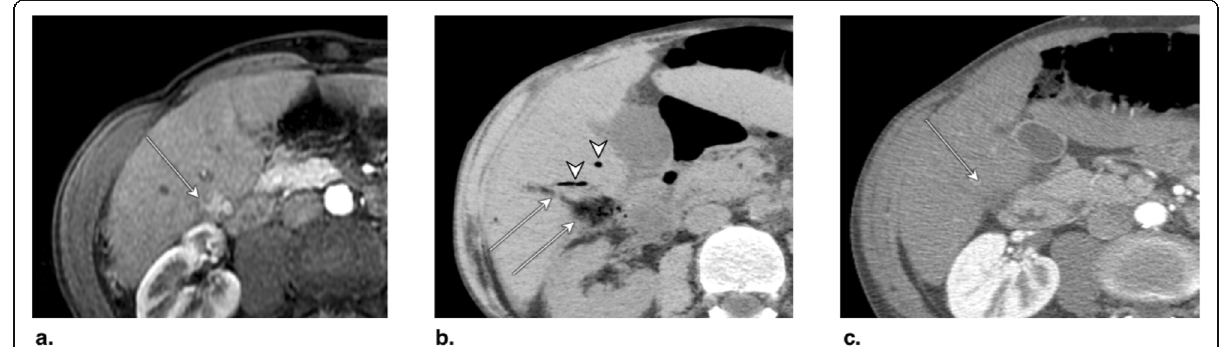
Fig. 8 a Axial T1-weighted MR in late arterial phase (AP) obtained pretreatment: image shows nonrim arterial phase hyperenhancement of a 2- cm LR-4 observation (arrow). b Axial-unenhanced CT MinIP obtained immediately post percutaneous ethanol ablation (PEA): image shows pneumobilia (arrowheads), ablation cavity, and needle trajectory (arrows). c Axial CT in late AP obtained 4 months post PEA: image shows no enhancement and cavity retraction (arrow). The treated observation is categorized LR-TR